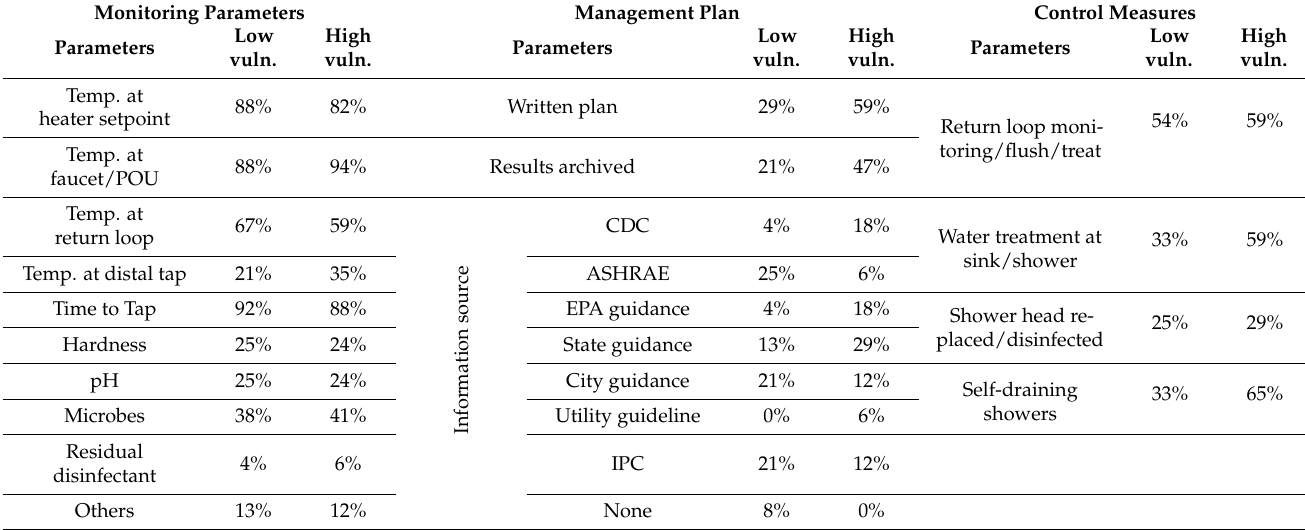
Table 3. Percentage responses of facility managers to building water quality monitoring, management plan, and control measure